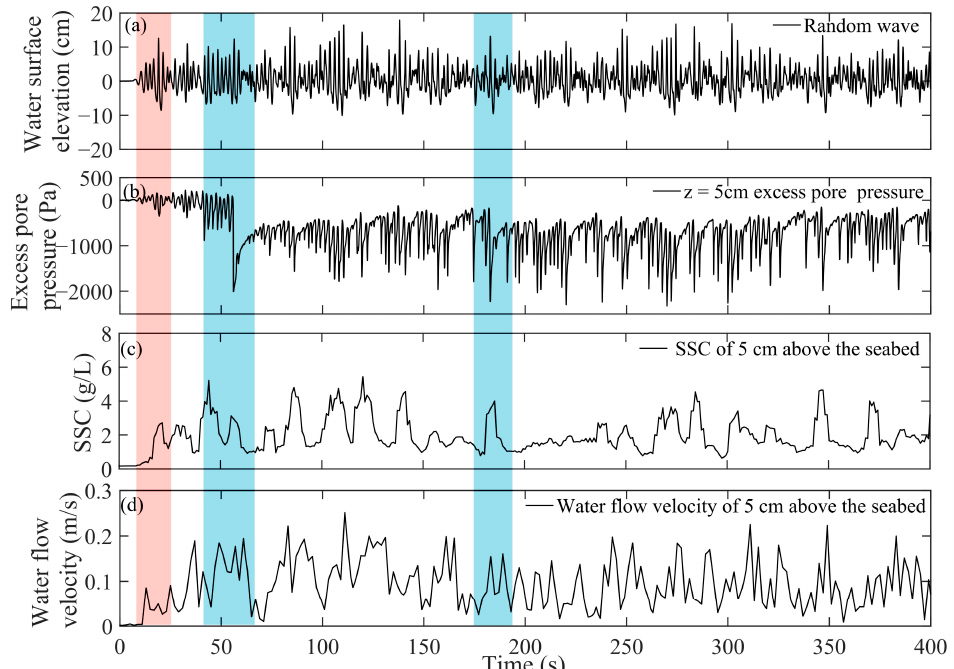
Figure 11. Changes through time in response to wave condition IV-2: ( a ) random wave elevation, ( b ) excess pore pressure (z = 5 cm), ( c ) SSC (at 5 cm above the seabed), and ( d ) the measured water flow velocity at 5 cm above the seabed.